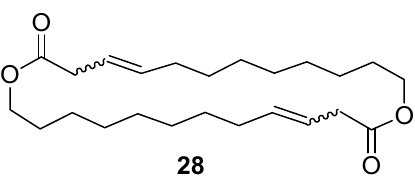
Figure 5. Lactone dimer intrinsic to the synthesis of 2 and / or 3 .